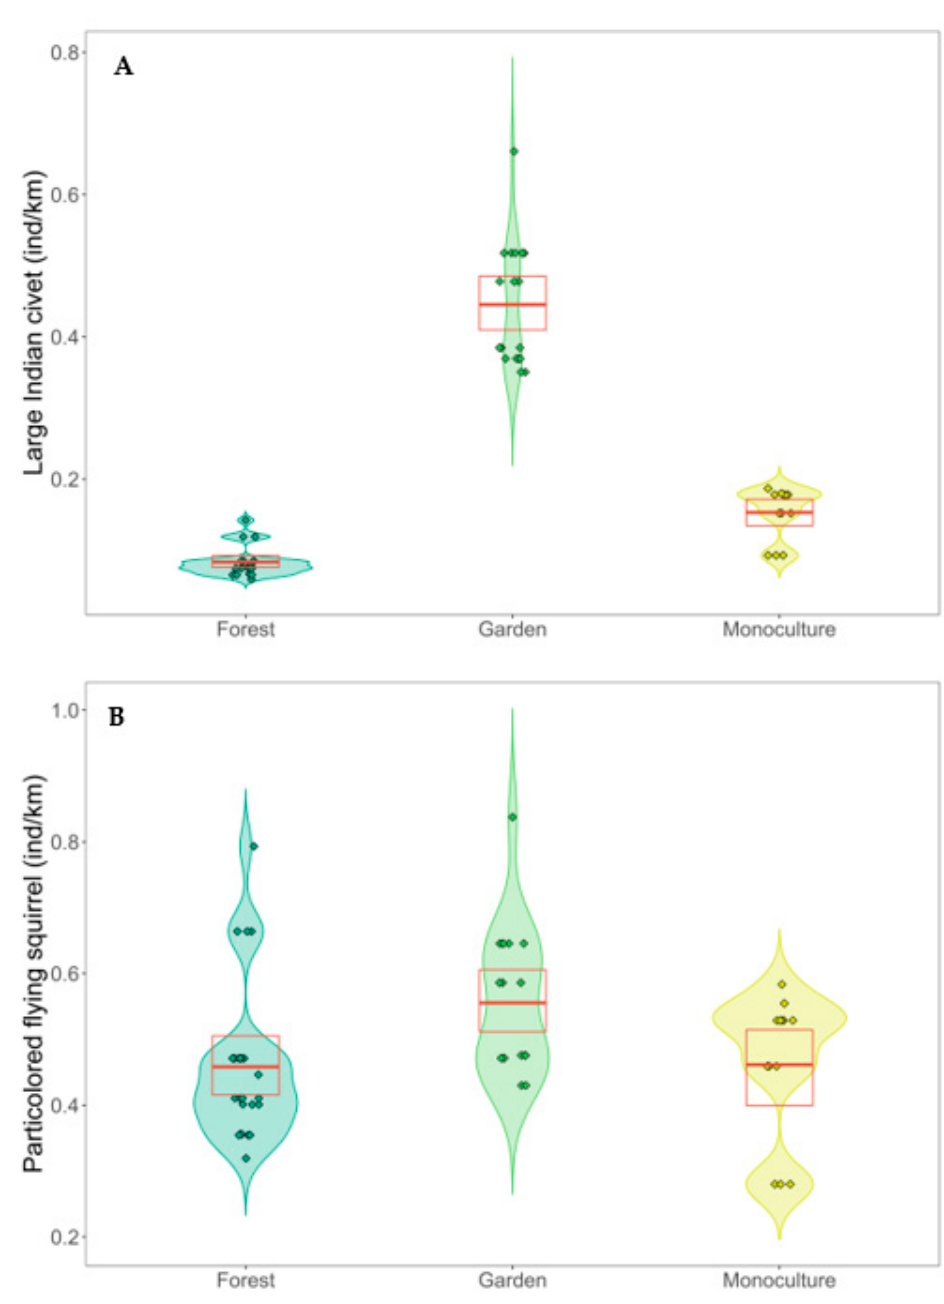
Figure 2. Significant results based on generalized linear mixed models showing the difference in encounter rates of large Indian civets ( A ) and particolored flying squirrels ( B ) between forest, gardens, and monocultures. Garden indicates mixed garden and semi-natural forest; monoculture indicates mixed monoculture and semi-natural forest. Data are predicted response values based on the model outcome; crossbars indicate means and 95% confidence intervals.